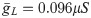
The optimal models show variability in individual and pairs of parameters.a. The range of parameters for all optimal models (~9000). Each parameter is normalized by its median value for cross comparison. The median values were g¯L=0.096μS, g¯H=0.164μS, g¯Ca=0.172μS, τmh=2179ms, V1/2Cam∞=−51mV, τmCa=70ms, V1/2Cah∞=−67mV, τhCa=458ms. Three representative optimal model parameter sets are shown (cyan, orange, purple solid line segments) indicating that widely different parameter combinations can produce the biological Z(f) and φ(f). CoV is coefficient of variation. b. Pairwise relationships among parameters of all optimal models (black dots). The range of parameter space was sampled within the prescribed limits given to the optimization routine, shown by including the sampled non-optimal models (grey). Permutation test showed significant pairwise correlations (green highlighted boxes with linear fits shown as green lines). c. Optimal models could be separated into two highly significant linear fits (green lines) in g¯Ca−V1/2Ca∞h according to whether g¯Ca < 0.05 (red; Low g¯Ca) or g¯Ca > 0.05 (cyan; High g¯Ca). d. All pairwise relationships, separated on the low or high g¯Ca (colors as in panel c). Green boxes are the same as in b.